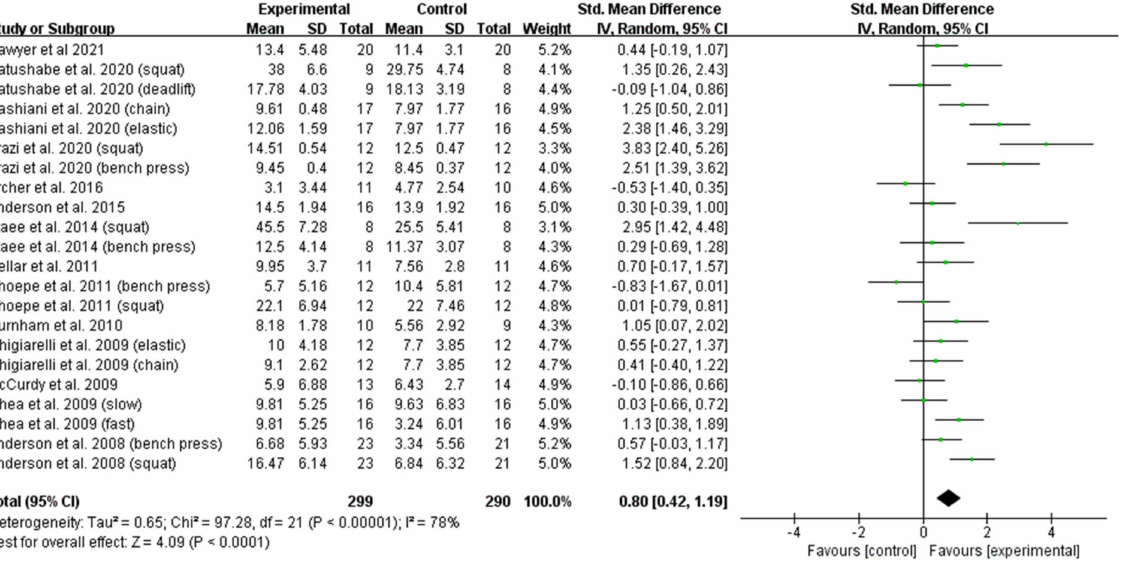
Figure 2. Forest plot of maximum-strength development comparison between VRT and